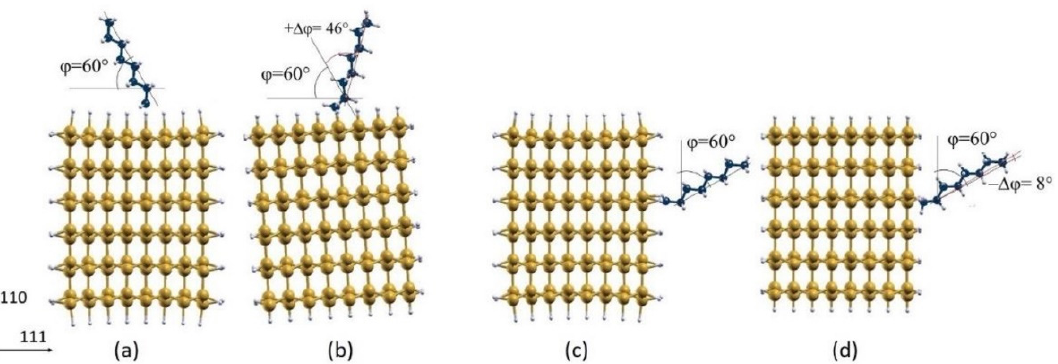
Figure 7. Initial ( a , c ) and optimized geometry ( b , d ) configurations of the octane moiety on the (111) ( a , b ) and (110) ( c , d ) surfaces of H-functionalized <112> oriented SiNWs (mustard color: Si atoms; white: H atoms; blue: C atoms).